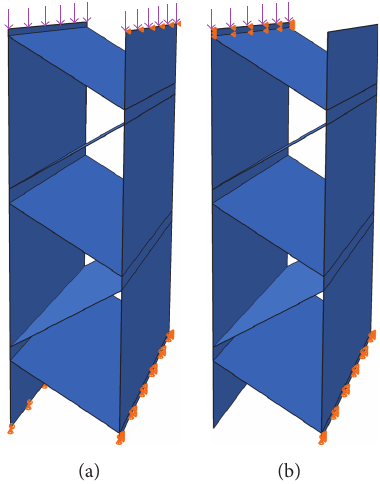
Figure 7: Loading condition (a: compression; b: shear).